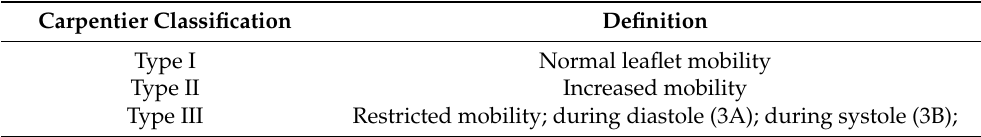
Table 1. Carpentier surgical classification of MV